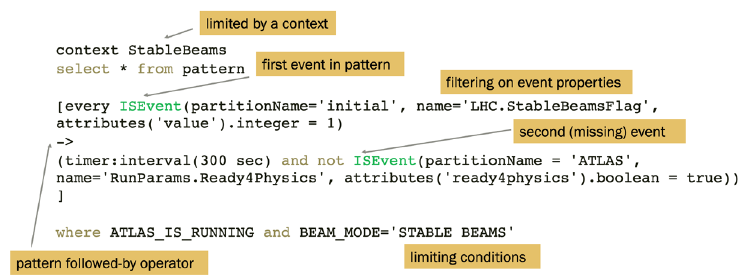
Figure 4. Example EPL of a SA directive using EPL